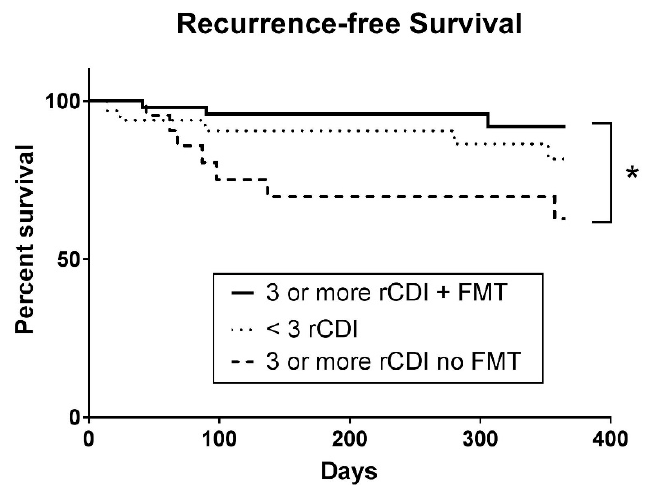
Figure 1. Recurrence-free survival in FMT and non-FMT groups. Recurrence-free survival analysis was performed using the Mantel–Cox log-rank test. The following three groups were compared: patients with three or more recurrent CDIs (rCDIs) who underwent FMT, patients with less than three rCDIs and therefore ineligible for FMTs, and patients with three or more rCDIs who deferred FMT due to other